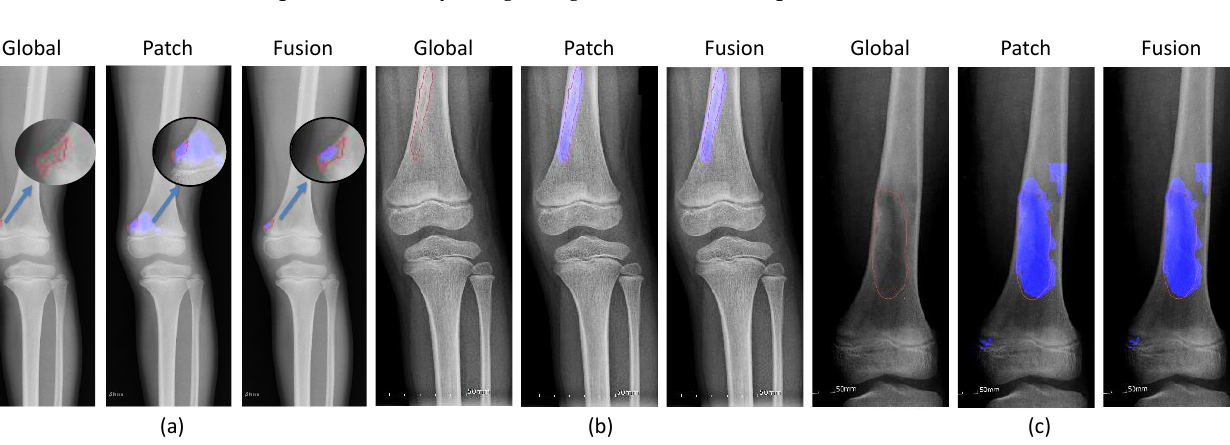
Figure 12. Successful cases of the patch-based model enhancing the fusion results with ( a ) small tumors, ( b ) long tumors, and ( c ) large tumors. (red line: ground-truth, blue region: tumor detection, blue arrow: zoom in the small ground-truth